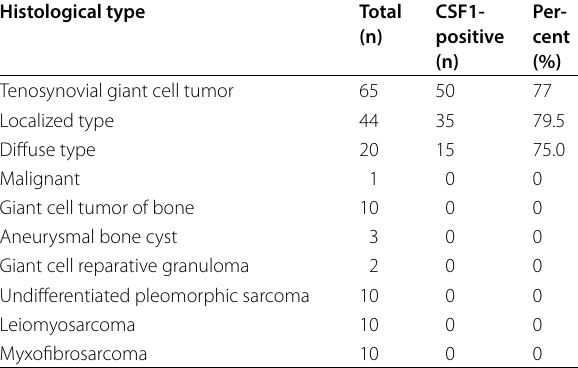
Fig. 5 CSF1 IHC and CSF1 split signal by FISH in TSGCT. a. CSF1-positive mononuclear tumor cells were scattered in the tumor b. The tumor cells showed a split signal pattern that consisted of a pair of split (red and green) and fused signals. The split signal was observed in 10% of tumor Table 2 CSF1 expression by IHC in giant cell-rich tumors and tumor-like lesions of the bone and soft tissue Histological type